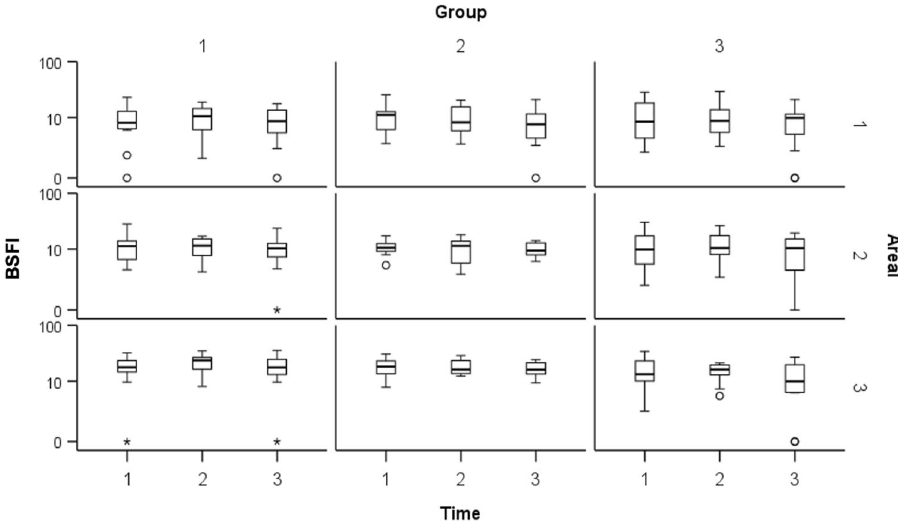
Figure 5. Background subtracted peak fluorescence intensity (BSFI) values of all groups (1 = control, 2 = nitroglycerine, 3 = volume) are shown in logarithmic form in boxplots at each measurement time (1 = Hypotension, 2 = Normotension, 3 = Hypertension) in each areal (1 = tip, 2 = corpus, 3 = prepyloric). Circles (°) represent mild outliers and asterisks (*) represent extreme outliers. The y-axis shows a logarithmic representation of the BSFI values while the other axes represent categorical variables. BSFI represents the difference in the initial intensity value before the injection of ICG was subtracted from the peak fluorescence intensity during the first passage of the dye through the gastric tube. Across all groups, areal 3 showed lower BSFI-values in group 3 compared to group 1 (p < 0.05). Group 2 showed similar trends, which were not statistically significant.